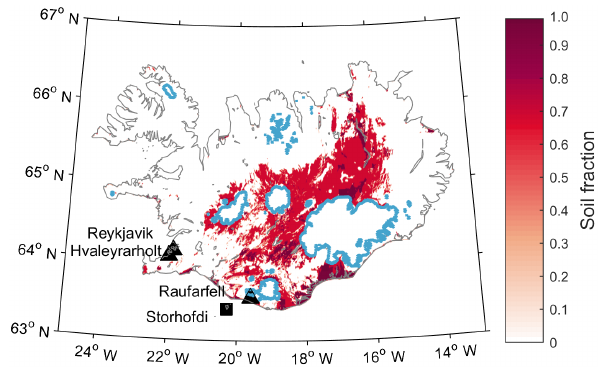
Figure 1. Aeolian active bare soil fraction as assumed in FLEX- DUST. The triangles indicate stations with PM measurements. The square marks the Stórhöfði station with dust concentration measure- ments. The blue lines are glacier